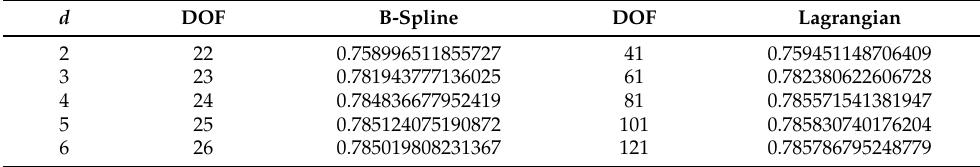
Figure 19. Relative error between transient and stationary solution in H 0 ( Γ ) norm at final time T = 300 versus shape functions degree d , having fixed space discretization step ∆ x = 0.1 and time step ∆ t = 0.2. Table 10. Space-time energy norm squared (60), varying d and fixing ∆ t = 2 − d ∆ x